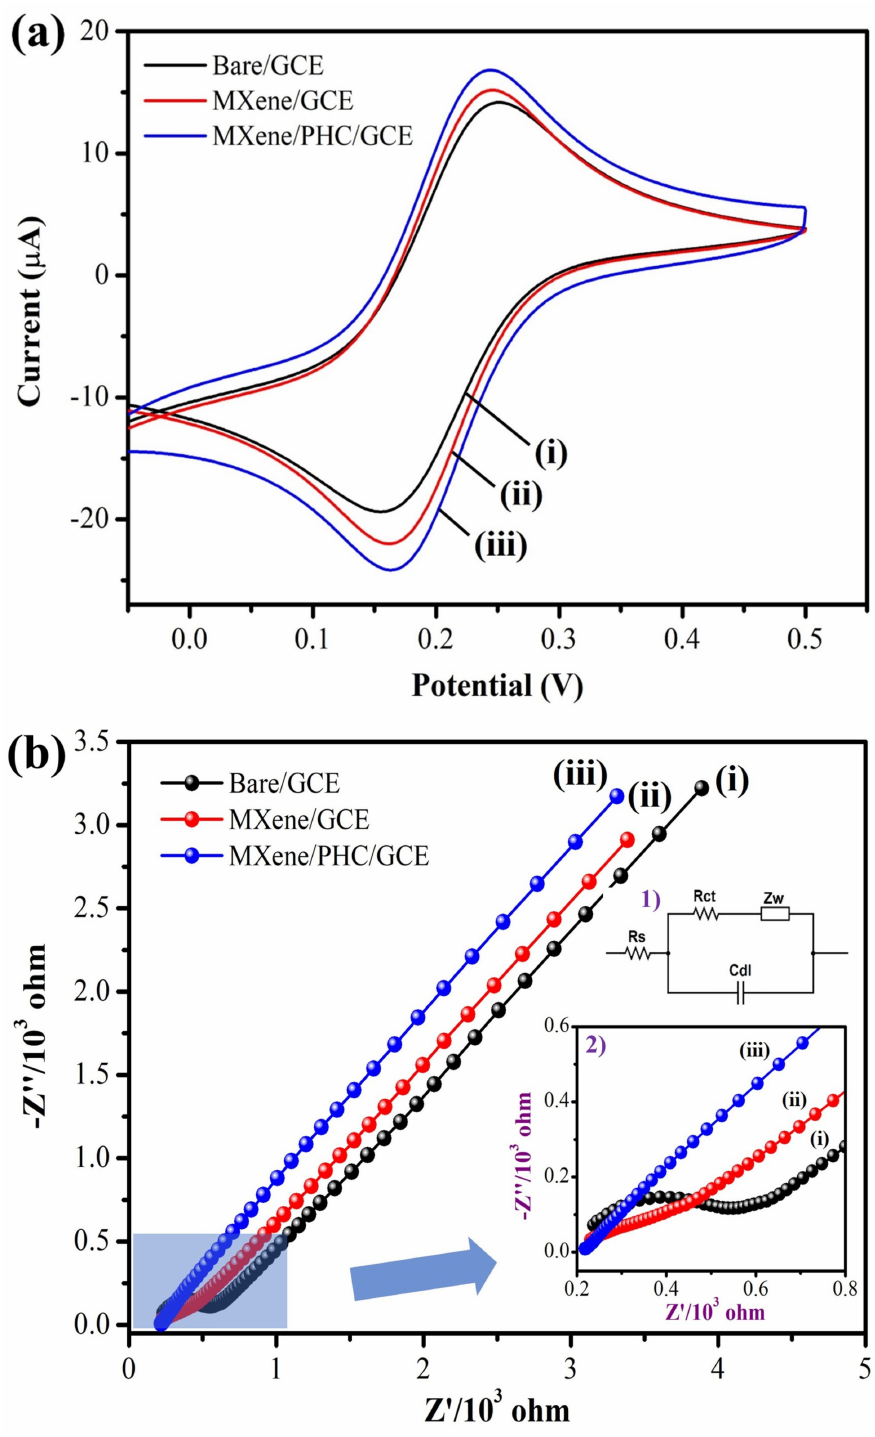
Figure 6. ( a ) CVs and ( b ) EIS spectra of ( i ) bare GCE, ( ii ) MXene/GCE and ( iii ) MXene/PHC/GCE in 0.1 M KCl with 2 mM [Fe(CN) 6 ] 3 − . Inset: ( 1 ) Randle’s circuit and ( 2 ) enlarged area of highlighted part of the